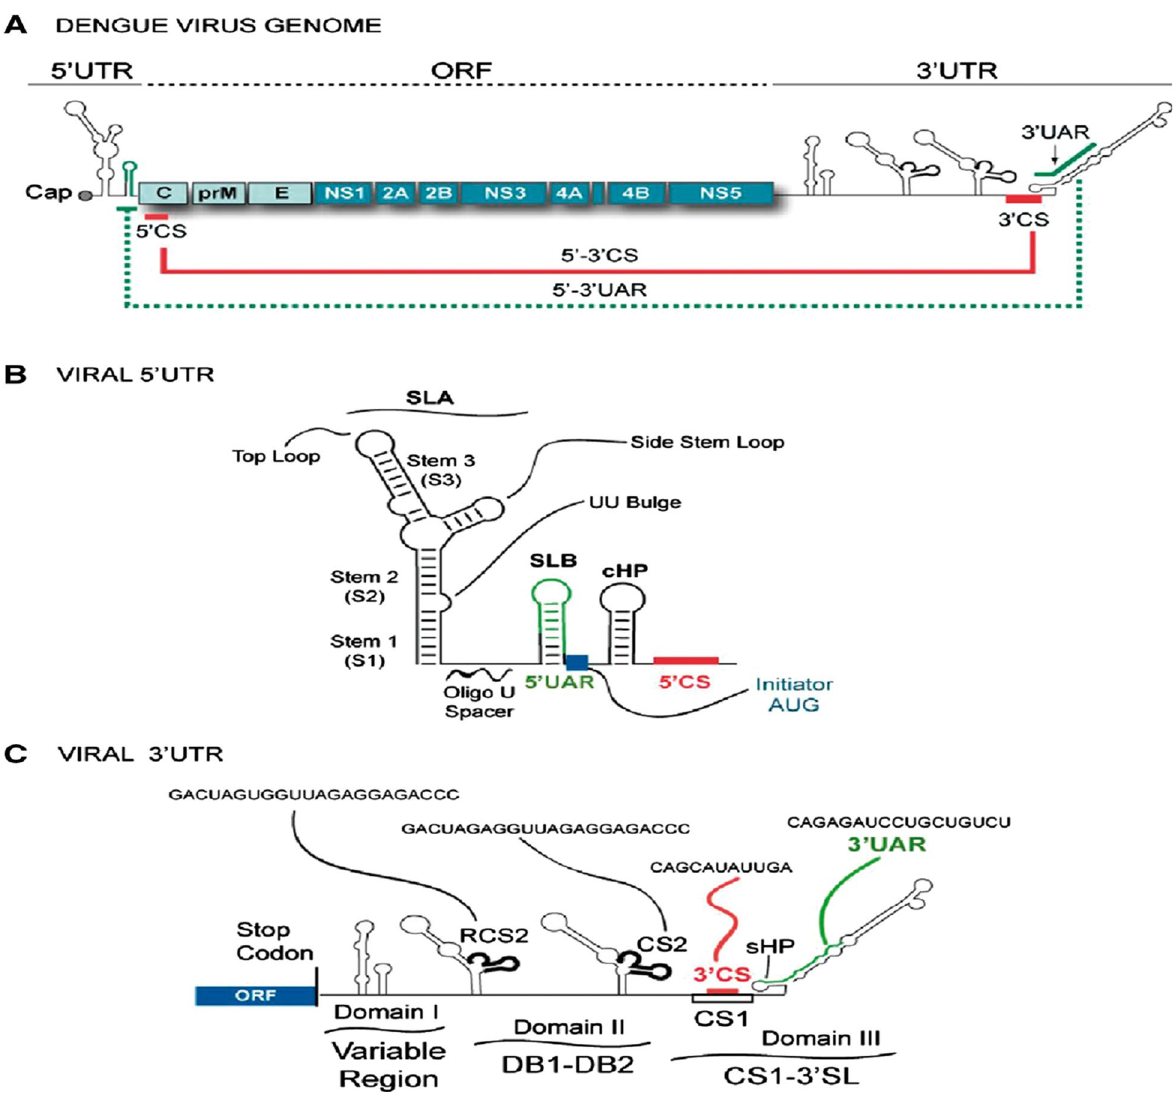
Fig. 2 Schematic representation of the DENV genome: A ORFs showing structural proteins (C-prM-E) and NS proteins (NS1–NS2AB–NS3–NS4AB– NS5) and 5 ′ and 3 ′ UTRs. Positions of complementary sequences are indicated by solid lines for 5 ′ –3 ′ CS and dashed lines for 5 ′ –3 ′ UAR. B Predicted secondary structure of the 5 ′ UTR of the genome. Structural elements of the 5 ′ terminal region include stem loop A (SLA), stem loop B (SLB), oligo (U) track spacer, translation initiator AUG, capsid region hairpin (cHP), and 5 ′ CS element. C Predicted representation of RNA elements at the 3 ′ UTR of the genome. Predicted secondary structures of three defined domains are shown: domain I (variable region, VR), domain II (dumbbell structure, DB1 and DB2), and domain III (conserved sequences CS1 and 3 ′ SL). In addition, the respective positions and sequences of the conserved elements corresponding to RCS2, CS2, 3 ′ CS and 3 ′ UAR are indicated